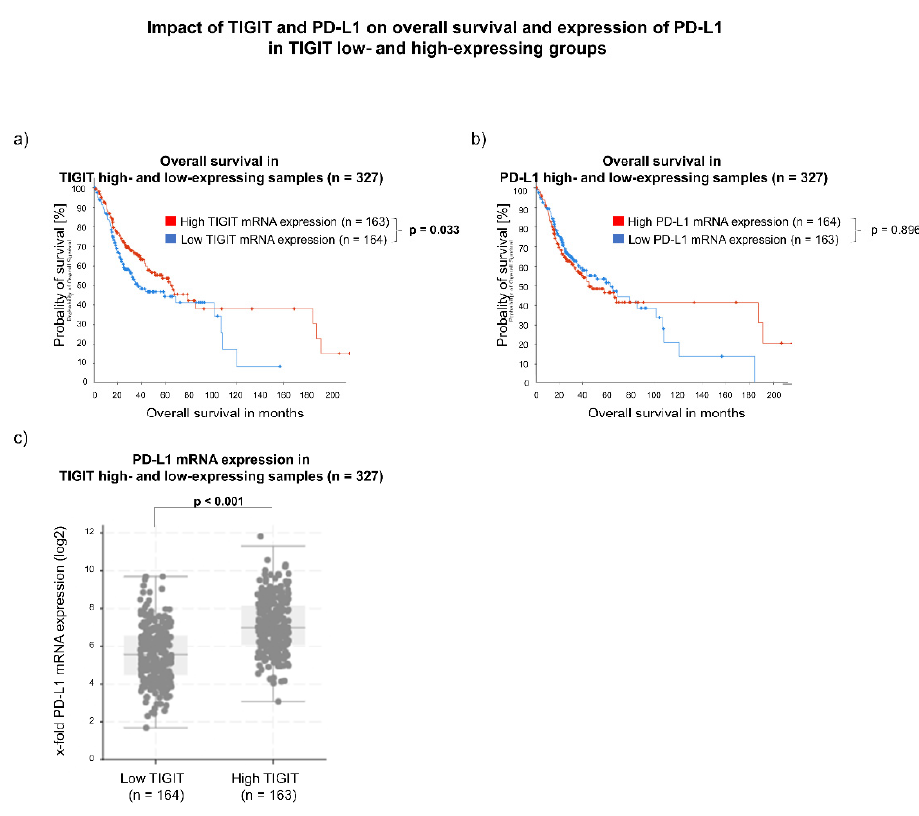
Figure 2. ( a , b ) Impact of TIGIT and CD274 mRNA expression levels on overall survival of OSCC patients, generated from the cBioPortal TCGA Firehose Legacy dataset. Groups were divided based on the median. ( c ) An additional analysis of TIGIT / CD274 co‑expression demonstrated higher CD274 levels in patients with high TIGIT mRNA expression